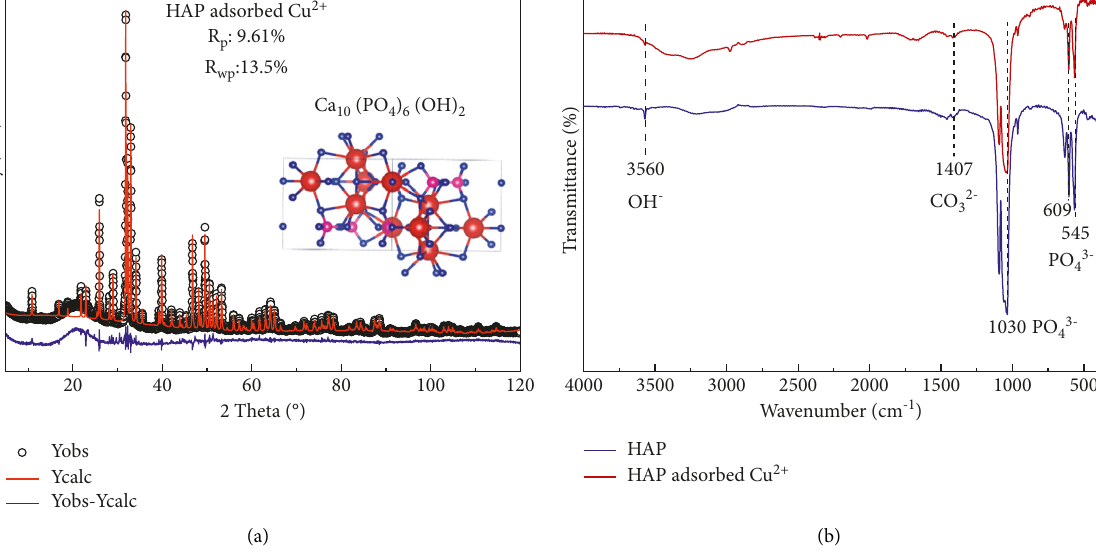
Figure 4: (a) X-ray diffraction patterns with Rietveld refinement of hydroxyapatite adsorbing copper. (b) FTIR spectra before/after adsorbing copper by